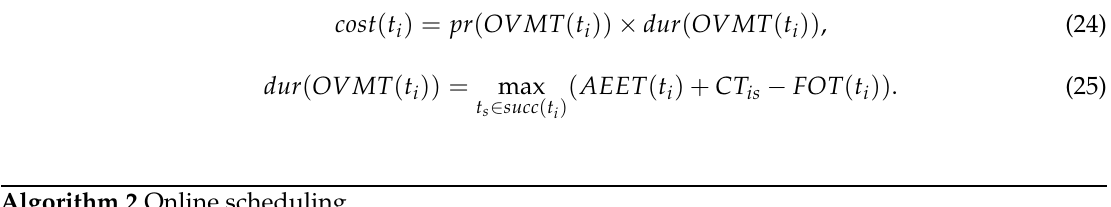
Algorithm 2 Online